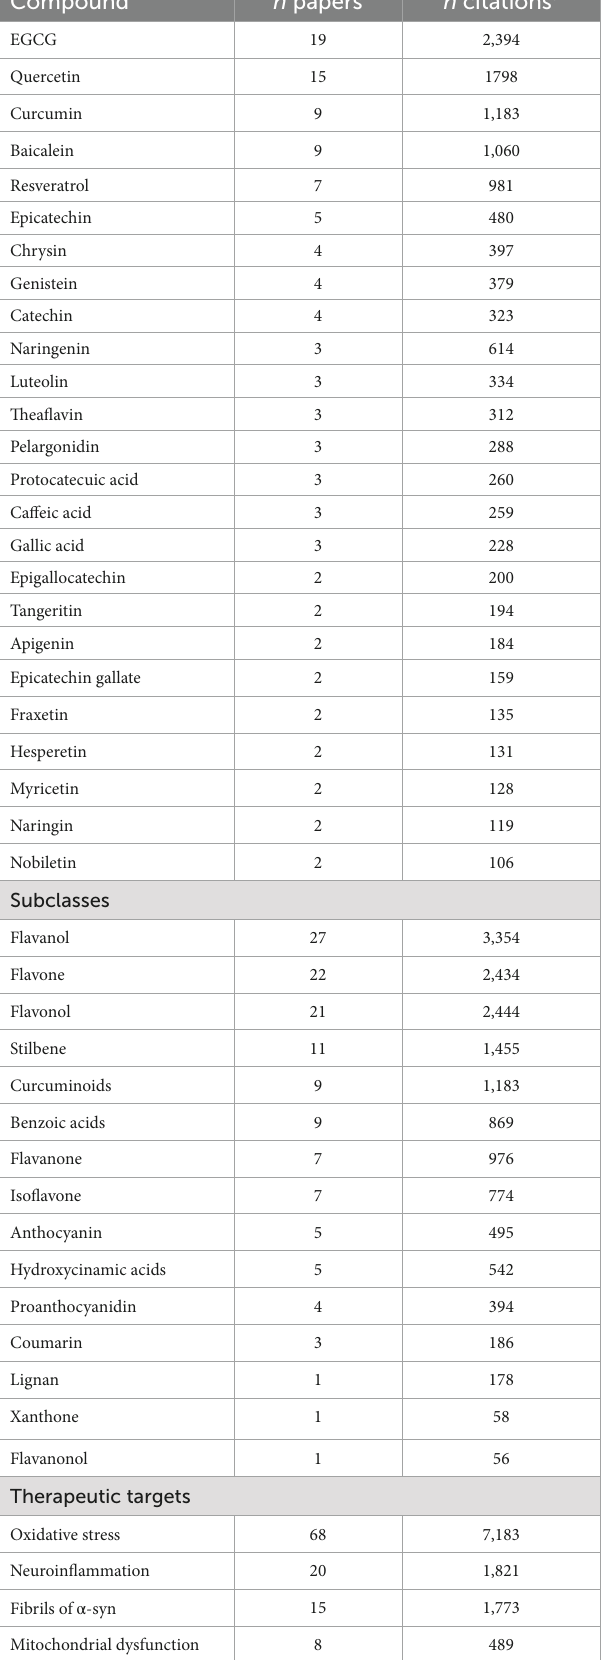
TABLE 4 Number of articles published by phenolic compounds, subclasses and therapeutic target.